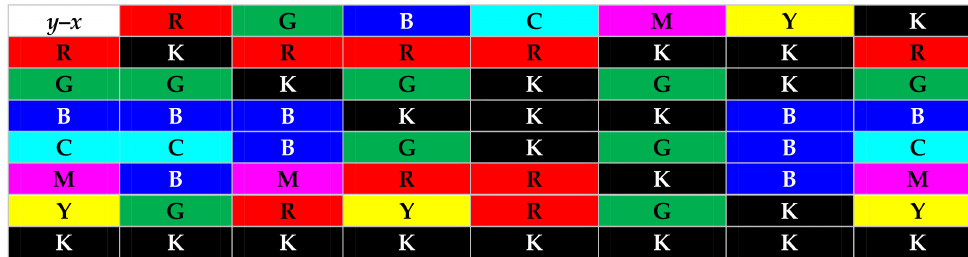
Table 1. Subtractive mathematical operations for a 3-bit additive color